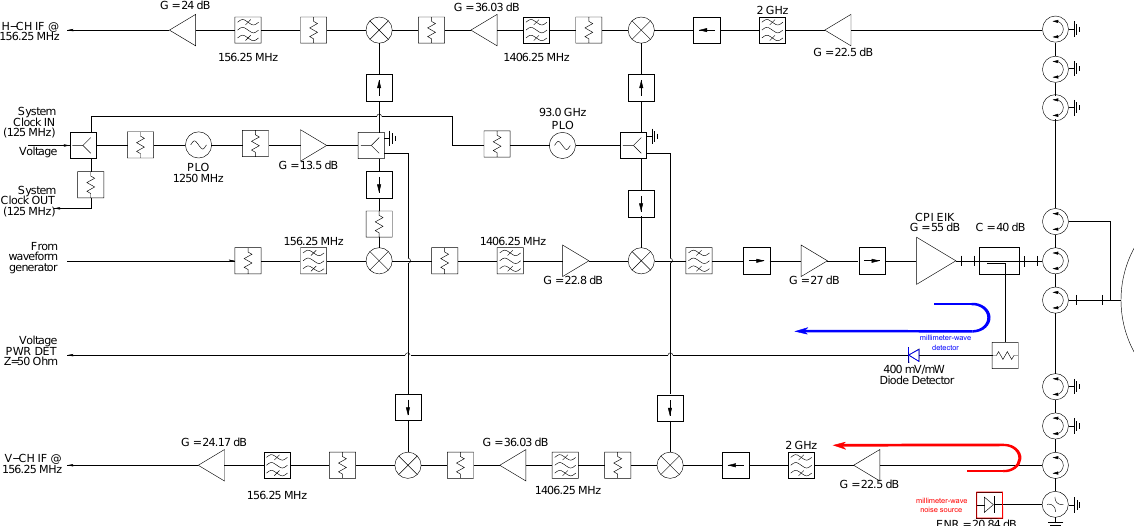
Figure 3. Block diagram of polarimetric HCR transceiver. The blue arrow couples the transmit signal for monitoring the transmitted power. The red arrow shows the signal path for monitoring receiver gain using a known noise source.